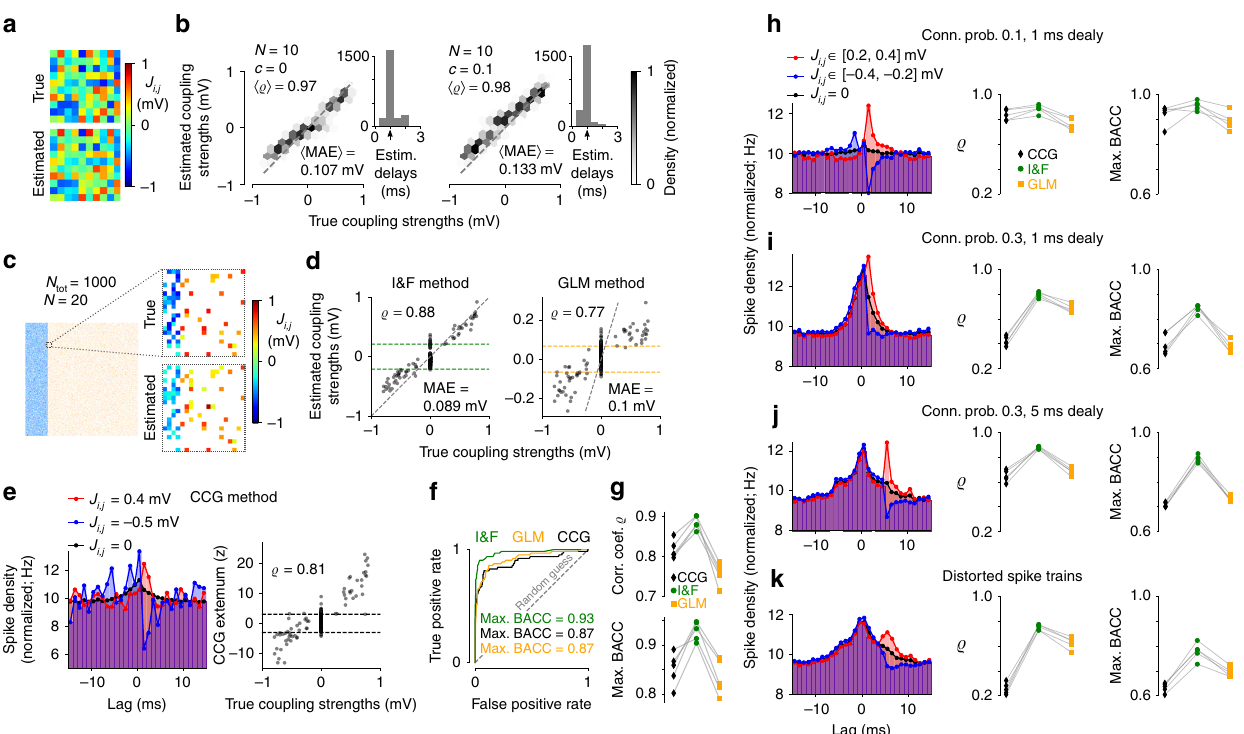
Fig. 5 Estimation results for synaptic coupling strengths using synthetic data. a Example coupling matrix using 5 min long spike trains from N = 10 neurons and estimation method 1a. b Density of estimated vs. true coupling strengths from 25 networks of N = 10 neurons for uncorrelated ( c = 0, left, as in a ) and correlated ( c = 0.1, right) external input fl uctuations. Average Pearson correlation coef fi cient 〈 ϱ 〉 and mean absolute error 〈 MAE 〉 between true and estimated coupling strengths are indicated. Insets: histogram of estimated delays across all networks, arrow marks the true (global) delay. c True and estimated coupling strengths of N = 20 neurons from a randomly coupled network of N tot = 1000 (800 excitatory, 200 inhibitory) neurons with connection probabilities of 0.1 for excitatory and 0.4 for inhibitory synapses, heterogeneous synaptic strengths and statistics of external inputs; c = 0, delay 1 ms. d – f Inference results from the I&F method compared to GLM- and CCG-based methods for the network in ( c ). d Estimated vs. true coupling strengths for the I&F method (left, as used in c ) and the GLM method (right). Dashed gray lines mark identity. A discrimination threshold for the presence of connections was applied (indicated by green and orange dashed lines; for details see Methods section “ Network model and inference details ” ). e Left: spike train CCGs for an excitatory connection (red), an inhibitory connection (blue) and averaged over all uncoupled pairs (black); right: CCG extremum z -score for positive lags vs. true coupling strengths, with discrimination threshold indicated. f Receiver operating characteristic (ROC) curves for the detection of synapses, i.e., true-positive rate vs. false-positive rate as the discrimination threshold varies, for the three methods. Indicated maximal balanced accuracy (BACC) values correspond to the thresholds visualized in ( d ) and ( e ), right. Dashed line represents random guessing. g Pearson correlation coef fi cient ϱ (top, cf. d and e , right) and max. BACC (cf. f ) for the three methods using fi ve different networks as in ( c ). Results from the same network are connected by gray lines. h – k Effects of connection probability and delay for subsampled networks of 500 excitatory and 500 inhibitory neurons. Left column: spike train CCGs averaged over subsets of excitatory (red) and inhibitory (blue) connections as indicated, and over all uncoupled pairs (black). Center and right columns: ϱ and max. BACC for the three methods (as in g ). Connection probability and delay values are indicated in ( h – j ); k setting as in ( j ), but spike trains were perturbed by a temporal jitter (random values in [ − 1, 1] ms). Other parameter values as in ( c ). Results in ( h – k ) are from fi ve networks each. In ( c – k ), 10 min long recordings were